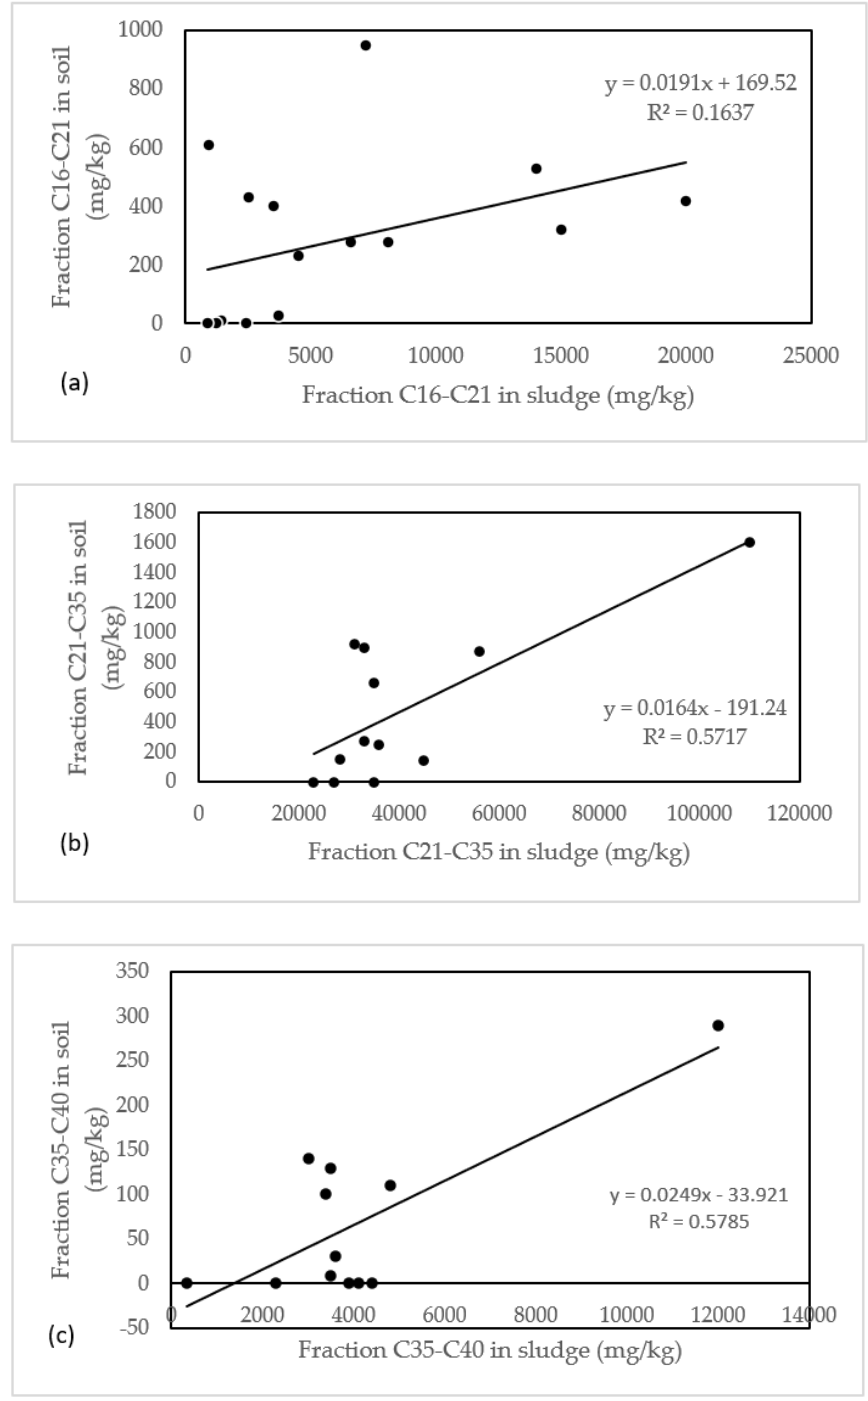
Figure 8. Relationship of aliphatic fractions ( a ) C16–C21, ( b ) C21–C35, and ( c ) C35–C40 between the sludge and the surface soil.